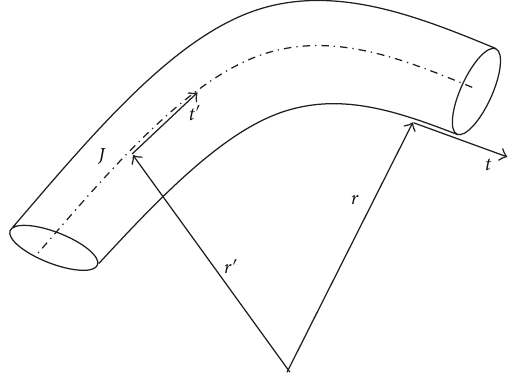
Figure 10: Thin wire